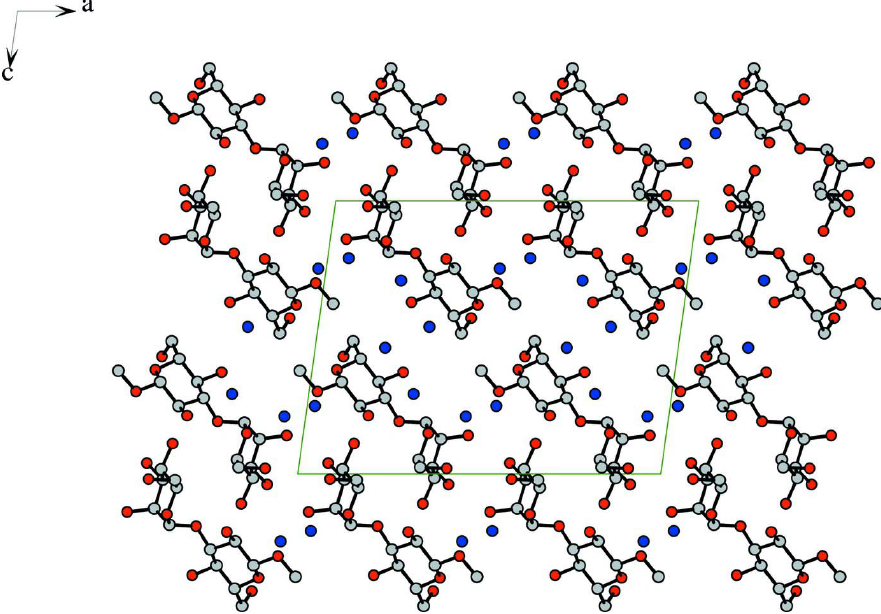
Figure 2 Crystal packing of the title compound, showing slightly more than one unit cell, viewed along the b axis direction. The water molecules between the sugar residues are situated in channels along the b-direction. Methyl 3-O- α -D-mannopyranosyl β -D-glucopyranoside tetrahydrate Crystal